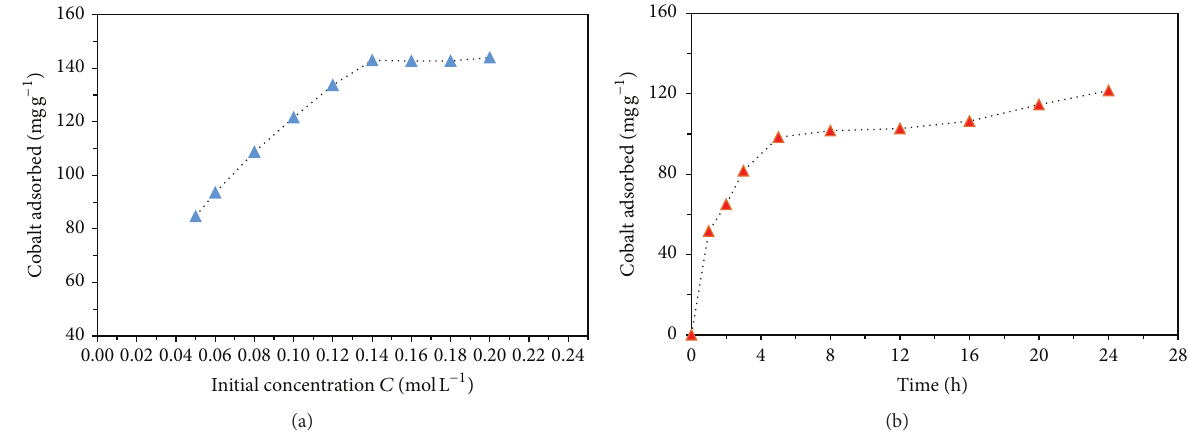
Figure 1: Effect of the initial concentration (a) and contact time (b) in the Co 2+ exchange at room temperature.